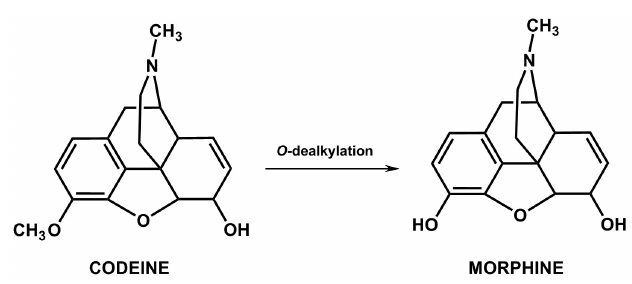
FIGURE 2 - Biotransformation of codeine, with the consequent release of morphine in vivo .